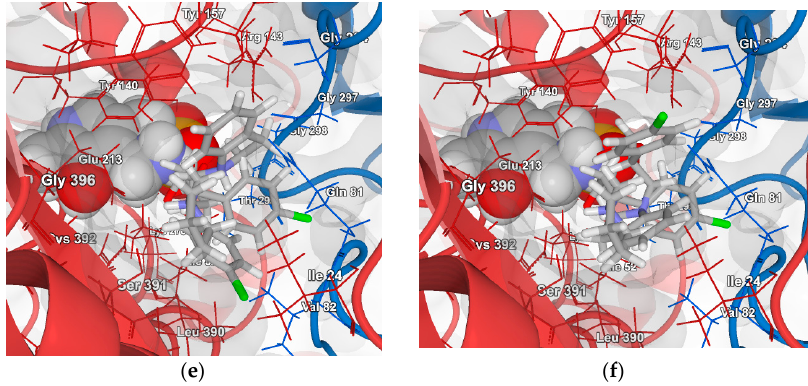
Figure 14. ( a ) Electrostatic potential map of human GABA-AT active site region. Blue, red and white colors represent regions with positive, negative and neutral electrostatic potential value, respectively; ( b ) GABA analogues bound into the human GABA-AT catalytic site; ( c ) (S) -Pregabalin analogues